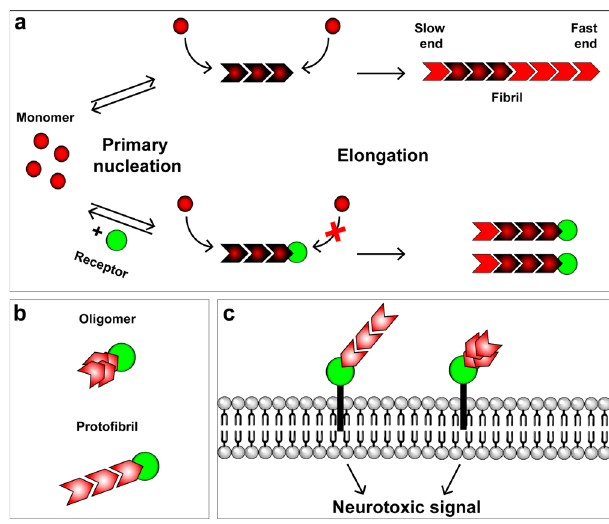
Fig. 9 Models for the interaction of receptors with A β fi brils, proto fi brils, and oligomers. a Schematic showing primary nucleation and elongation steps in the A β polymerization process in the absence (upper pathway) and the presence (lower pathway) of a receptor protein, such as PrP C , Fc γ RIIb, or LilrB2. The receptor binds to the fast-growing end of the fi bril, blocking elongation at that end, and restricting elongation to the slow-growing end. Secondary nucleation events are not depicted. b Interaction of a receptor with neurotoxic oligomers and proto fi brils. Receptors bind to one end/edge of these assemblies, possibly recognizing the same structural determinant present at the fast-growing end of fi brils. c Binding of A β oligomers and proto fi brils to membrane-anchored receptors initiates neurotoxic signaling. Receptors may also trap or concentrate oligomers and proto fi brils on the cell